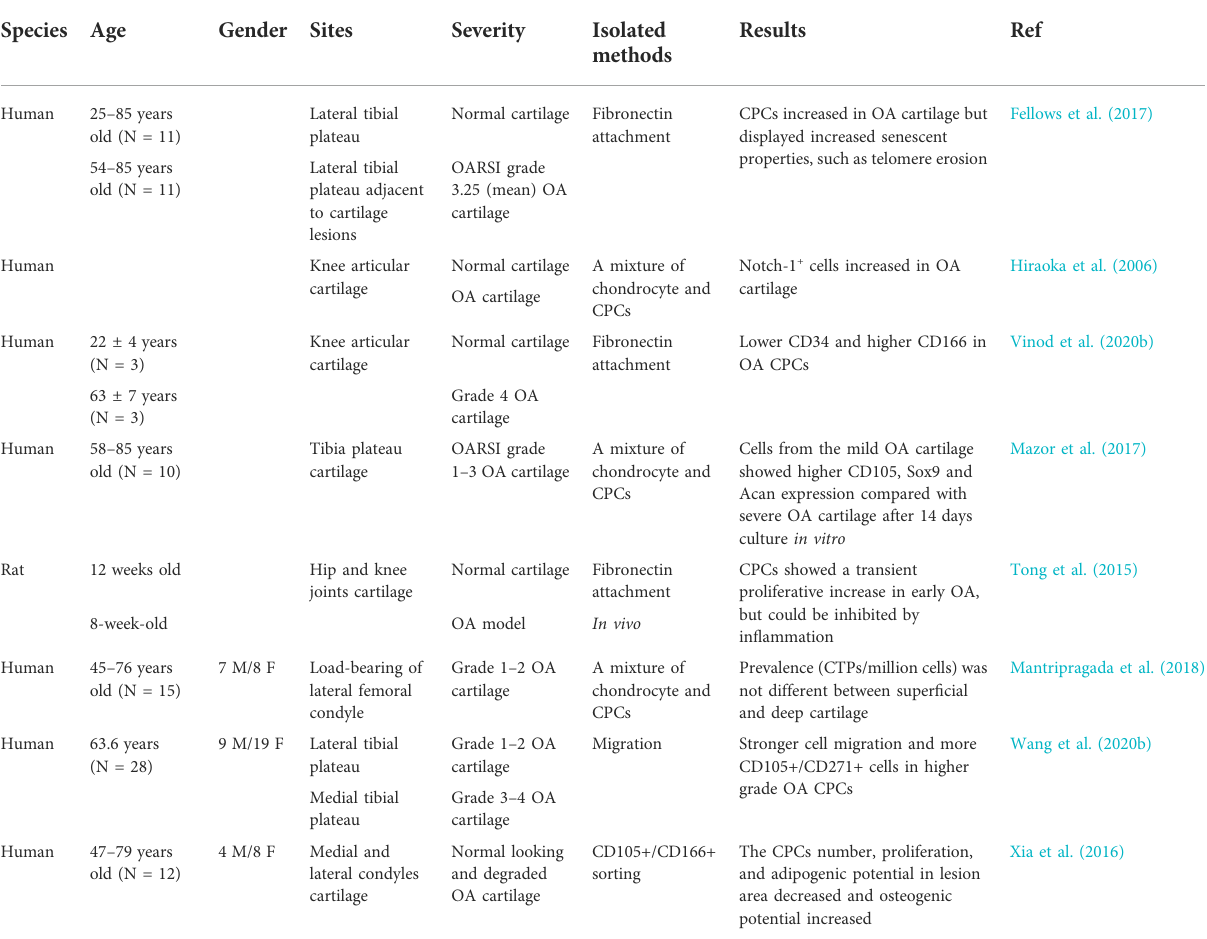
TABLE 3 The comparison of CPCs in normal and OA